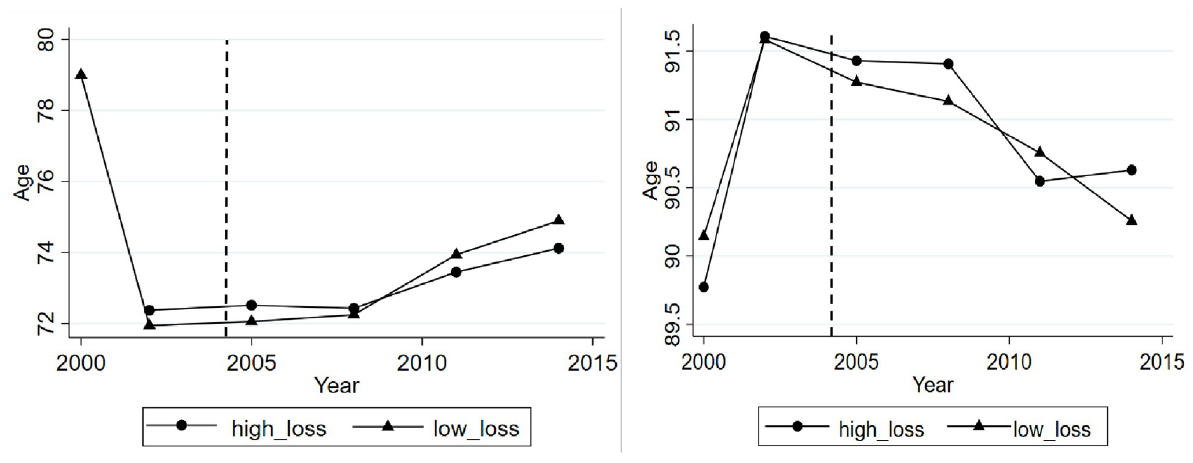
Fig 2. Chemical fertilizer loss and age of